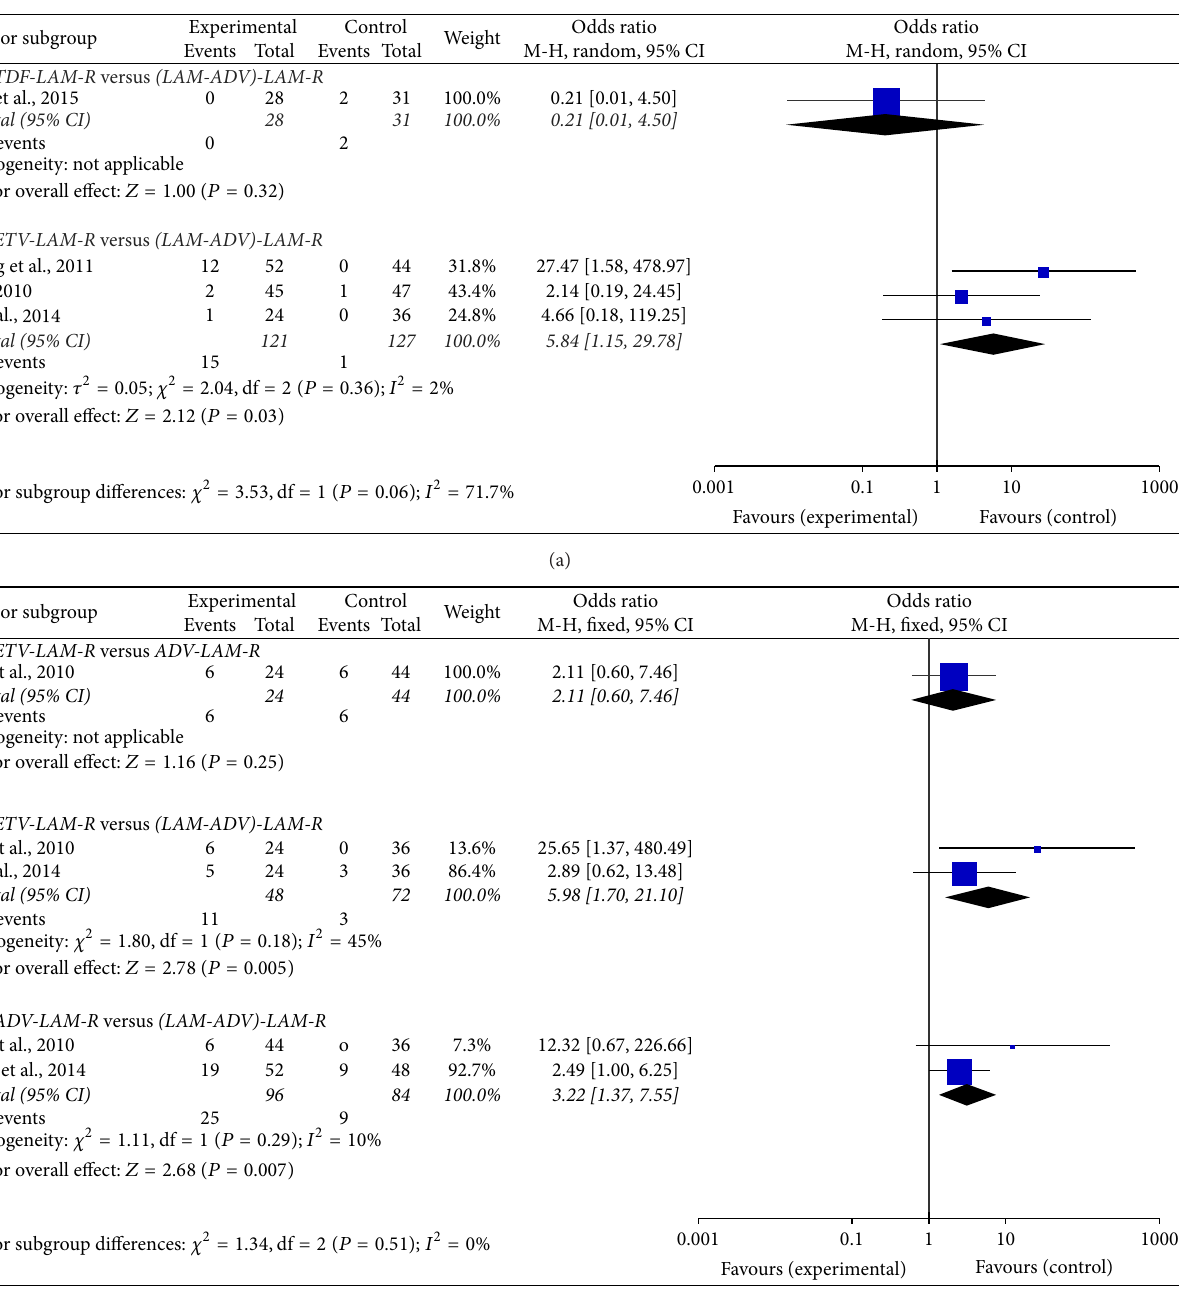
Figure 2: Forest plot of direct meta-analysis of viral breakthrough and genotypic resistance. (a) 48 weeks; (b) 96 weeks.